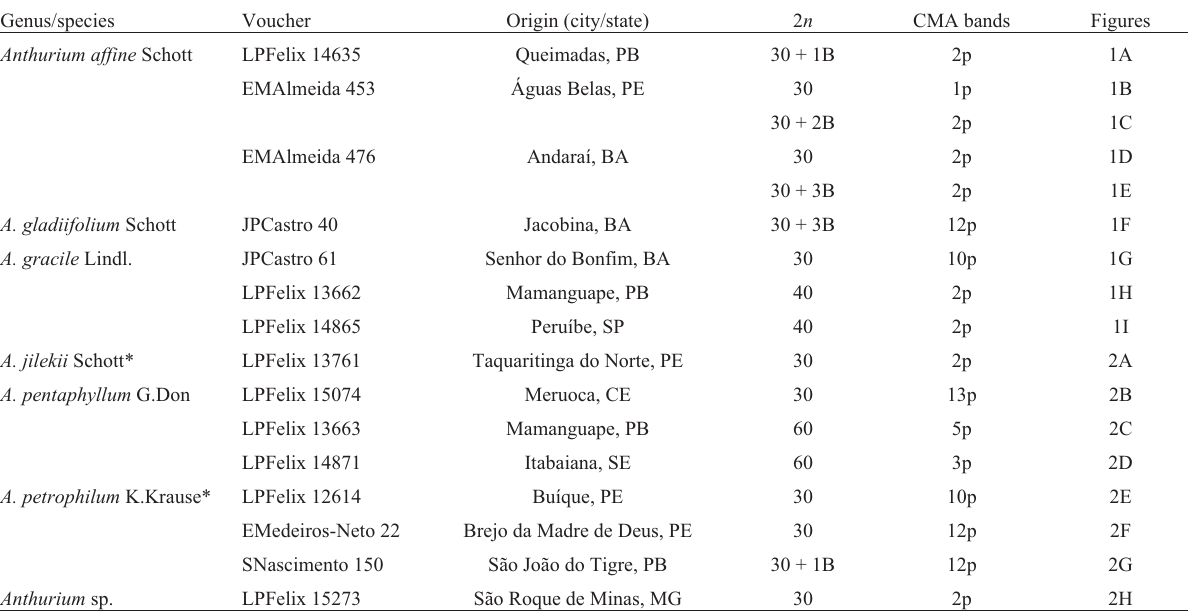
Table 1 - The Anthurium species analyzed, citing their origins, voucher numbers, chromosome numbers, CMA/DAPI bands, and figures.